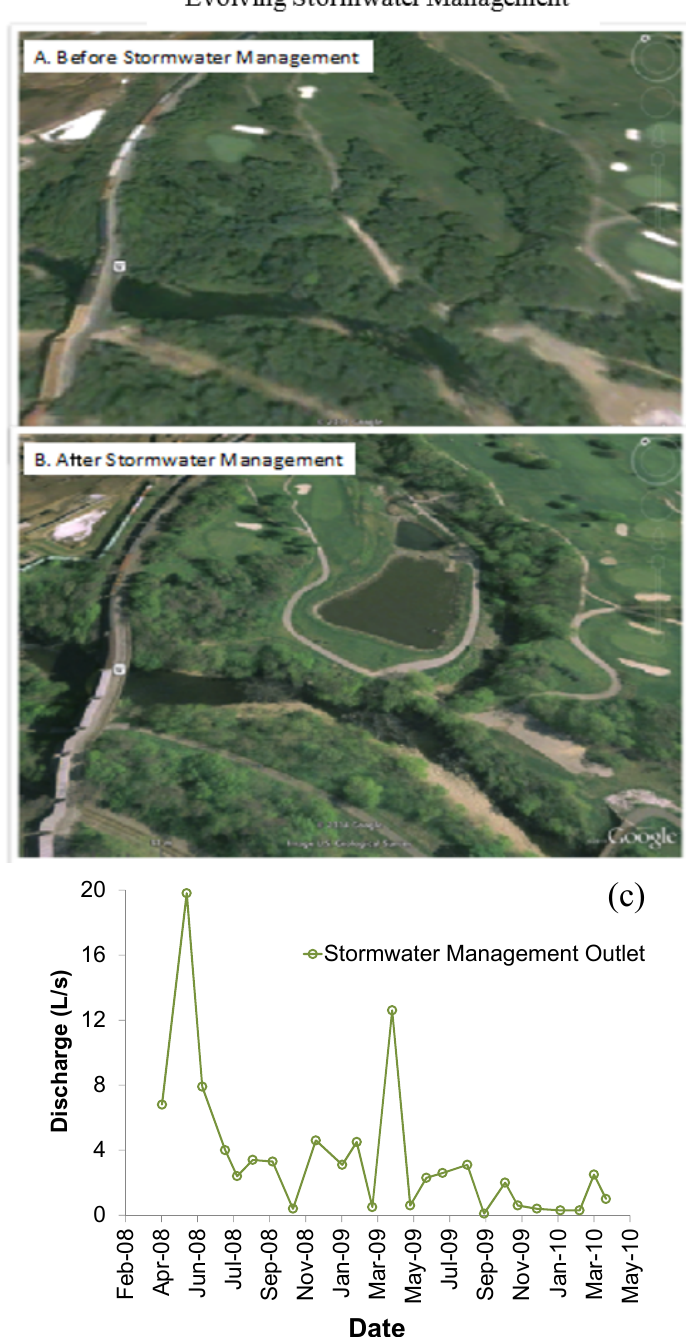
Figure 2. Aerial photography from Google Earth showing ( A ) before and ( B ) after the addition of stormwater management in the Gwynns Run watershed in Baltimore, MD, USA; There has been a decline in discharge from stormwater management over time due to growth of macrophytes, accumulation of trash at the inlet, and sedimentation in the stormwater management controls [10] ( C